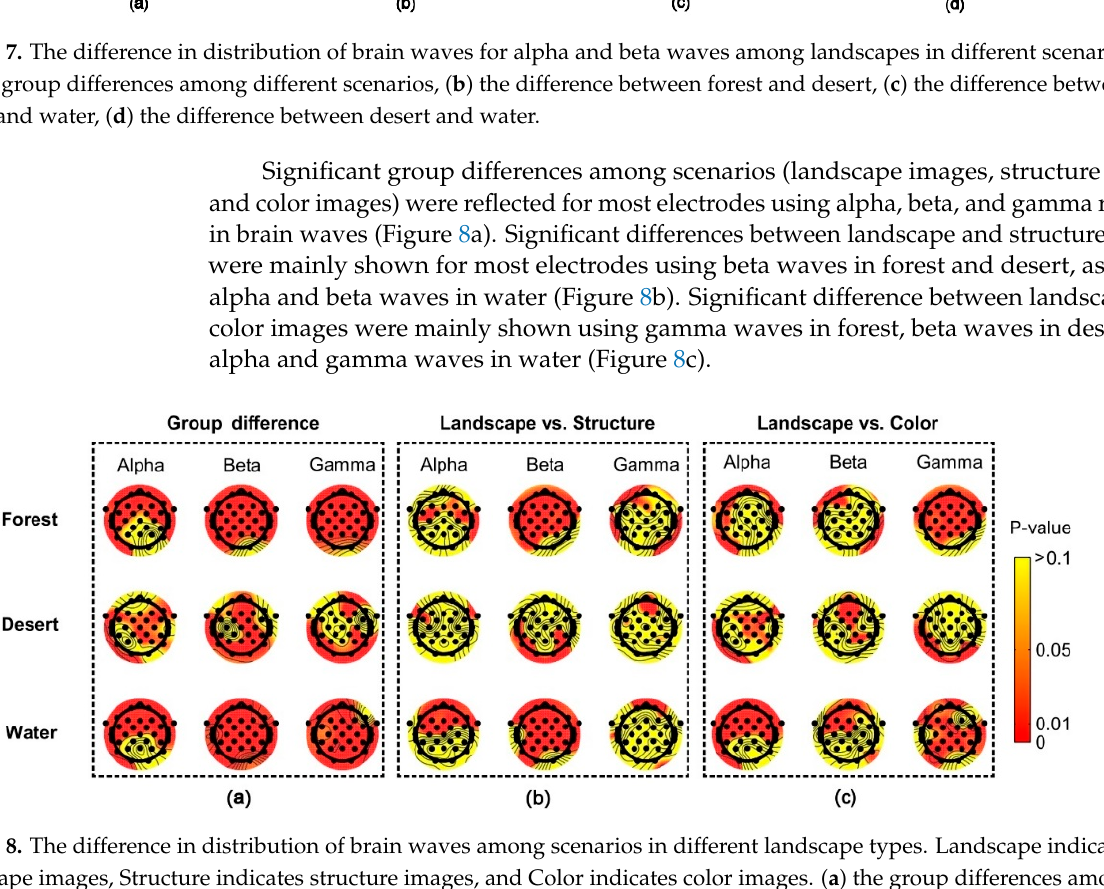
Figure 8. The difference in distribution of brain waves among scenarios in different landscape types. Landscape indicates landscape images, Structure indicates structure images, and Color indicates color images. ( a ) the group differences among different landscape types, ( b ) the difference between landscape images and structure images, ( c ) the difference between landscape images and color images.